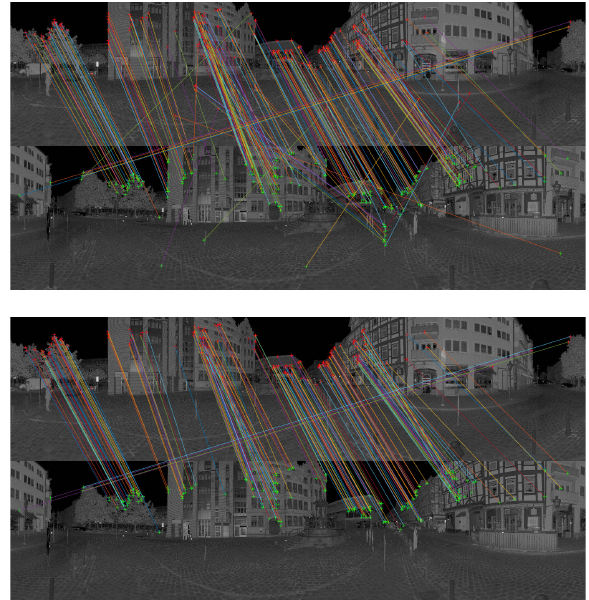
Figure 3. Feature correspondences between the panoramic inten- sity images of scans S 1 and S 2 when using the combination of an A-KAZE detector and an M-SURF descriptor: all correspon- dences (top) vs. inlier correspondences